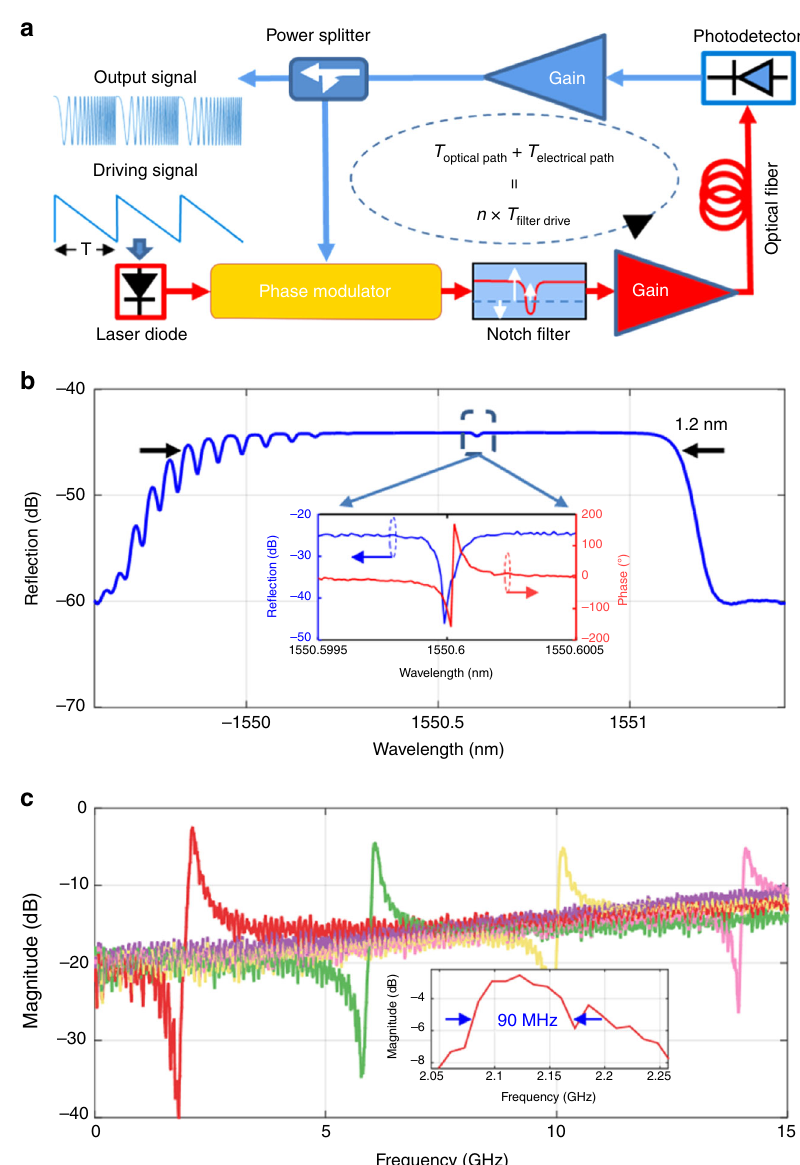
Fig. 2 Experimental setup and microwave photonic band-pass fi ltering principle. a Experimental setup of the FDML OEO. Light from a laser diode is phase modulated and then is directed into an ultra-narrow optical notch fi lter. Oscillation frequency is determined by the wavelength difference between the carrier wavelength and notch wavelength. A frequency-selected microwave is generated at the output of a photodetector, and ampli fi ed in a gain medium. Part of the ampli fi ed microwave signal is fed back to the phase modulator to close the OEO oscillation loop. b Re fl ection spectrum of the PS-FBG. The inset shows the phase and magnitude responses around the notch. c Frequency response of the microwave photonics band-pass fi lter with the central frequency tuned from about 2 GHz to about 14 GHz with a tuning step of about 4 GHz. The inset shows the zoom-in view of the frequency response when the center frequency is tuned at about 2.1